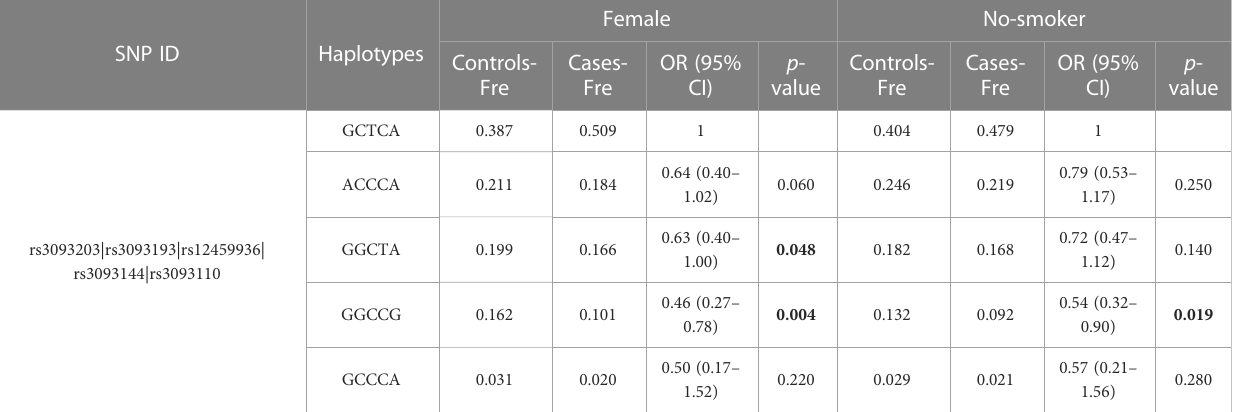
SNP, single nucleotide polymorphism, OR, odds ratio, CI, con fi dence interval. p <0.05 indicates statistical signi fi cance. Signi fi cant values are marked in